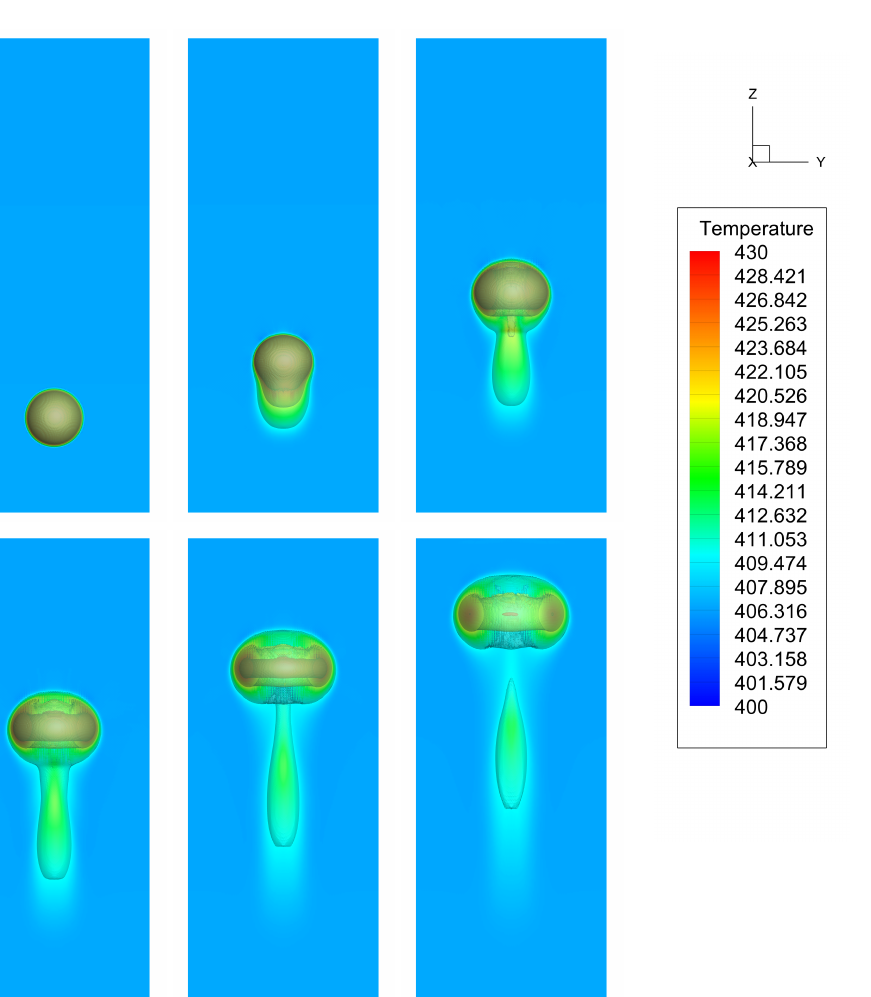
Figure 16. Temperature contours at plane x = 0 and isosurfaces T to bottom right : t = 0, t = 1, t = 2, t = 3, t = 4, t =